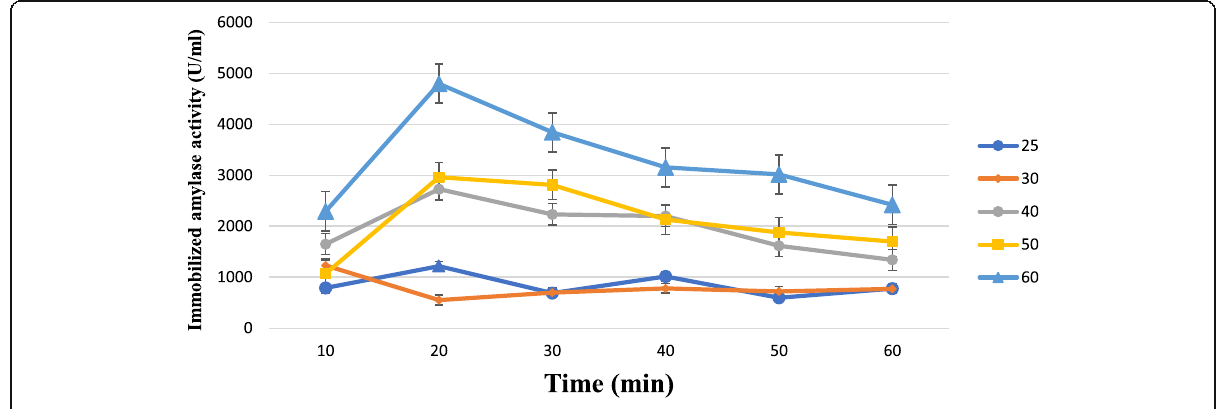
Fig. 8 Thermal stability of immobilized amylase by Aspergillus terrus